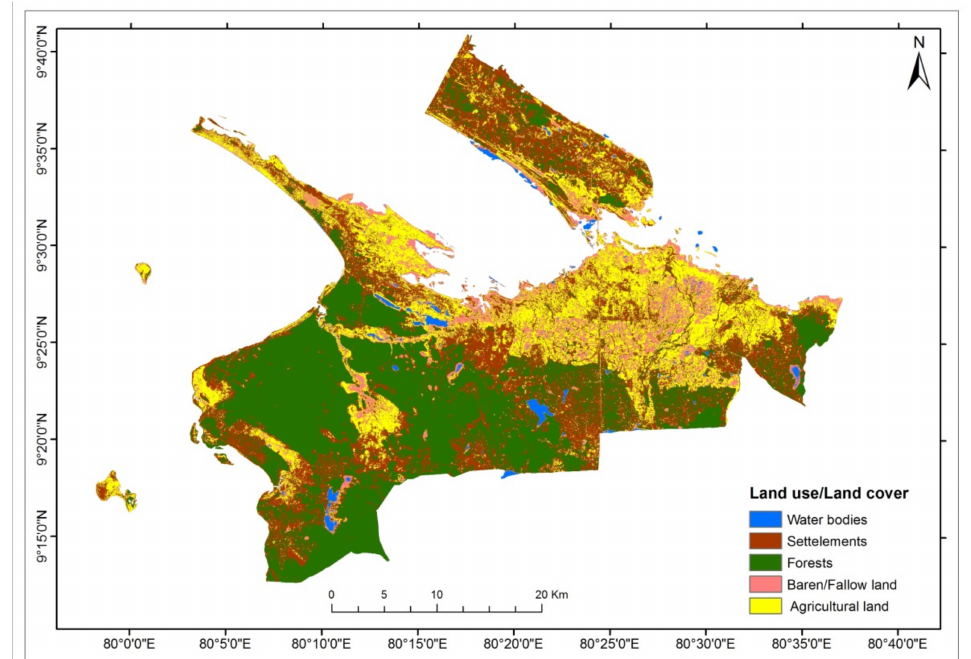
Figure 11. Map of land use/land cover of Kilinochchi